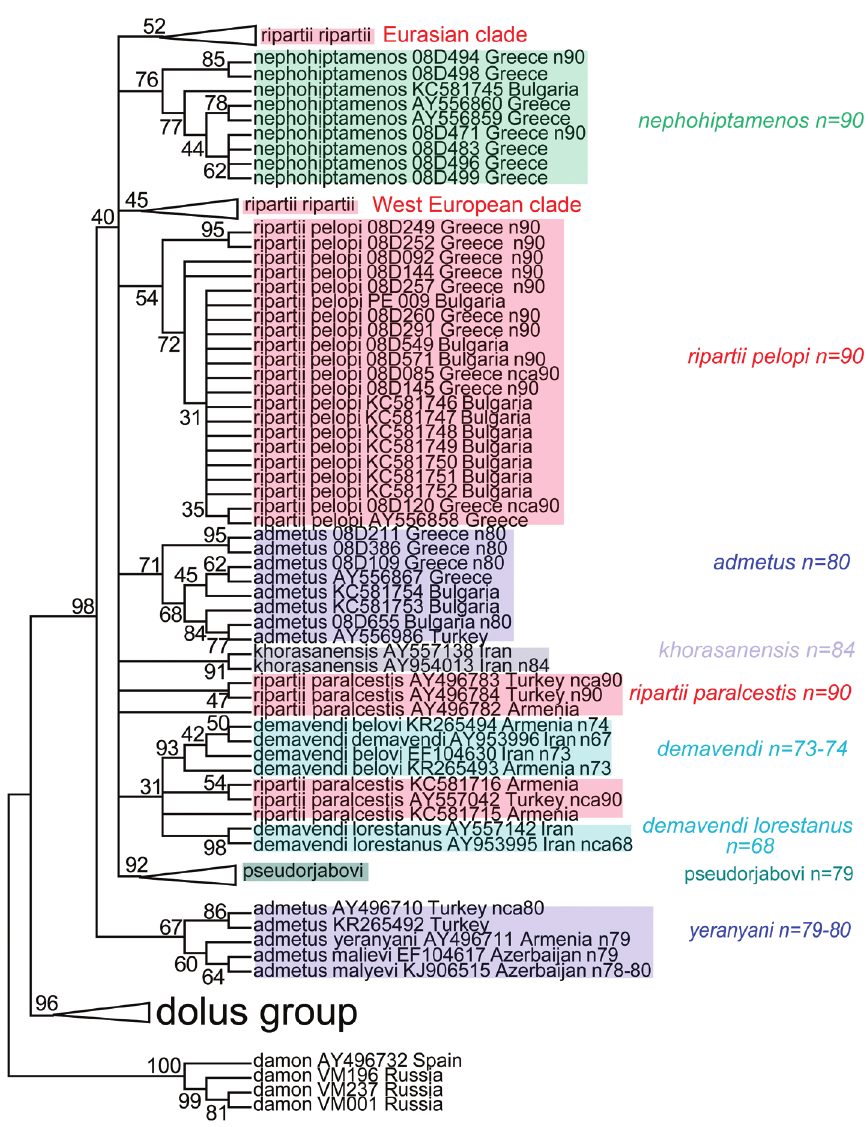
Figure 18. Fragment of the ML tree of P. admetus and P. dolus complexes based on analysis of COI barcodes and focused on P. nephohiptamenos , P. admetus and P. ripartii pelopi . Polyommatus pseudorjabovi clade is not shown in details, for its composition see Lukhtanov et al. (2015a). Details of the West-Eu- ropean and the “mixed” (Eurasian) clades of P. ripartii are shown in Fig. 19. Details of the Polyommatus dolus group are shown in Fig. 20. Numbers at nodes indicate bootstrap